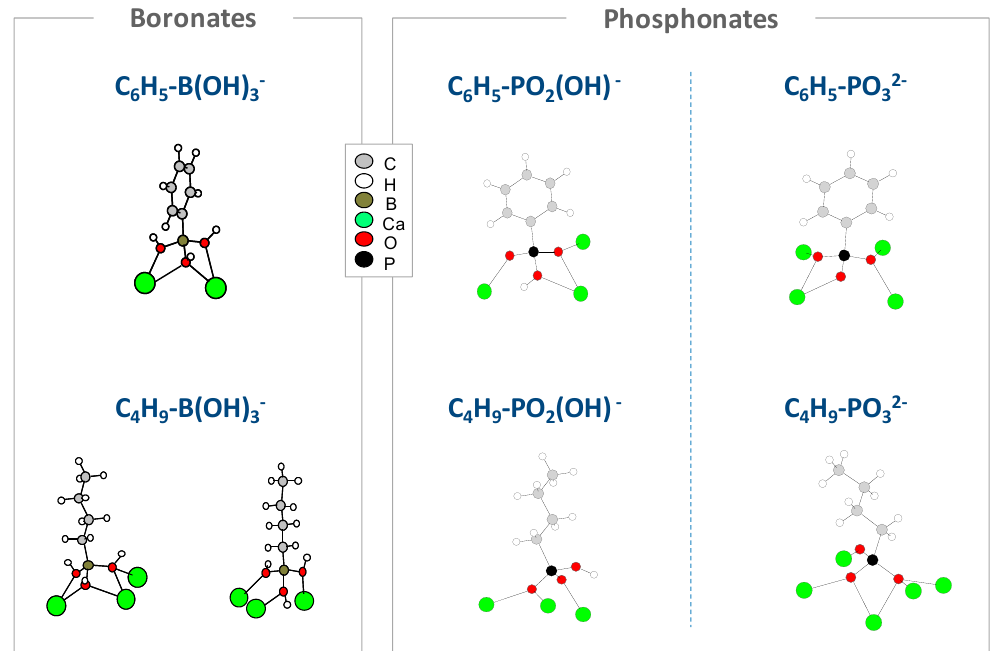
Figure 12. Comparison of the coordination modes observed for phosphonates and boronates with respect to calcium in different crystal structures. Adapted with permission from [22] (copyright American Chemical Society, 2011), [23,24] (copyright Wiley-VCH Verlag 2013 and 2015), [25] (copyright Actualité Chimique, 2014), and [37] (copyright Royal Society of Chemistry 2013).